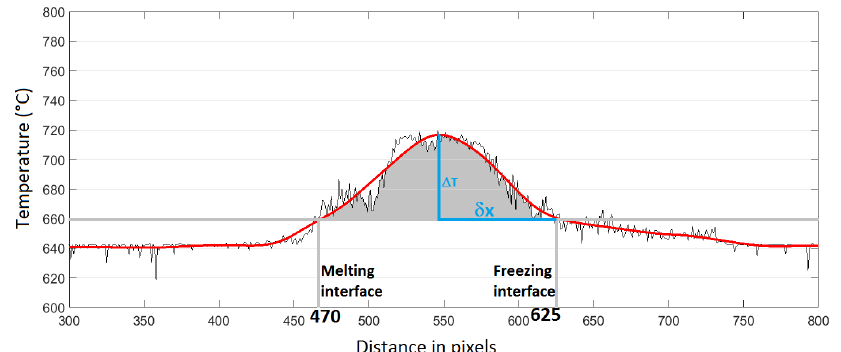
Figure 10. Temperature profile of the exemplary Frame 210 showing the region over the liquidus temperature of aluminum, as well as the ∆ T and δ x.